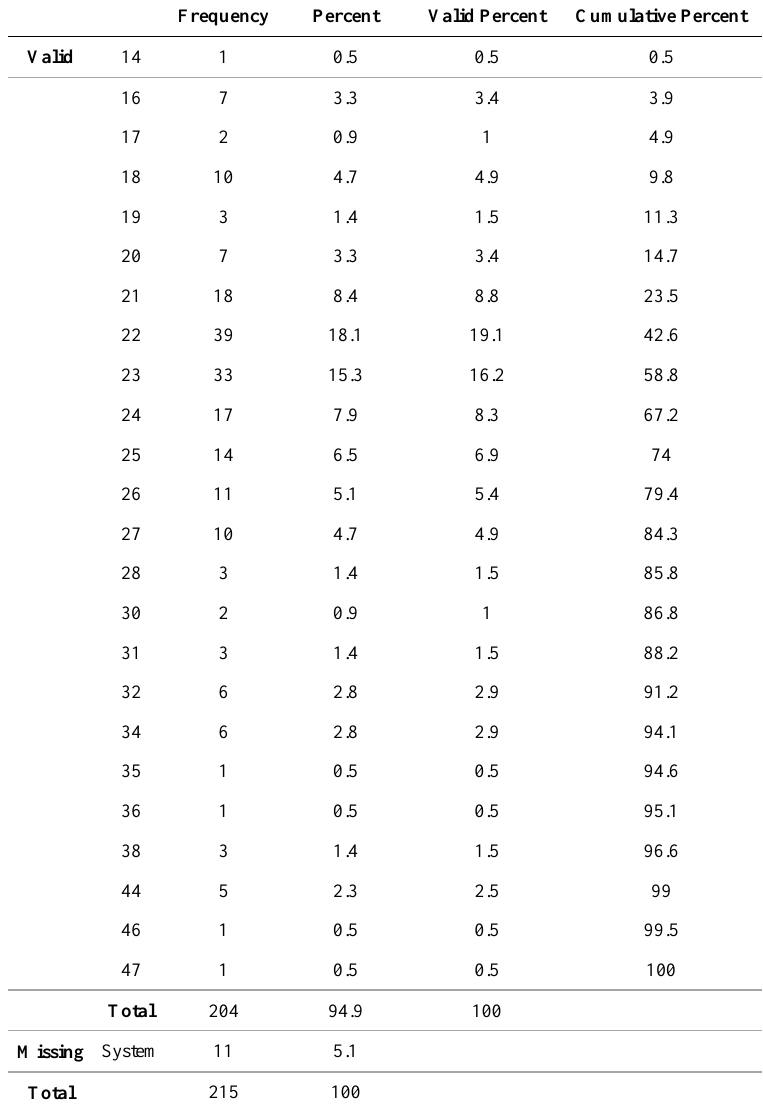
Table 5. Age (Questionnaire